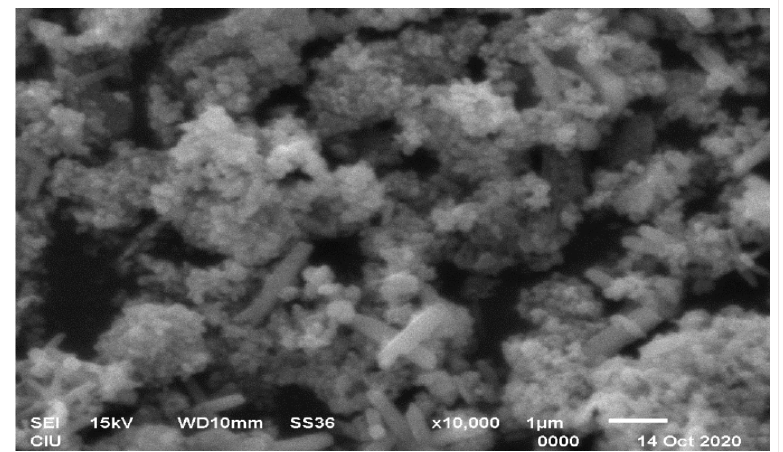
Figure 2. SEM image of Al 2 O 3 -ZnO-Fe 3 O 4 nanocomposite. The particle size distribution is important in the characterization of